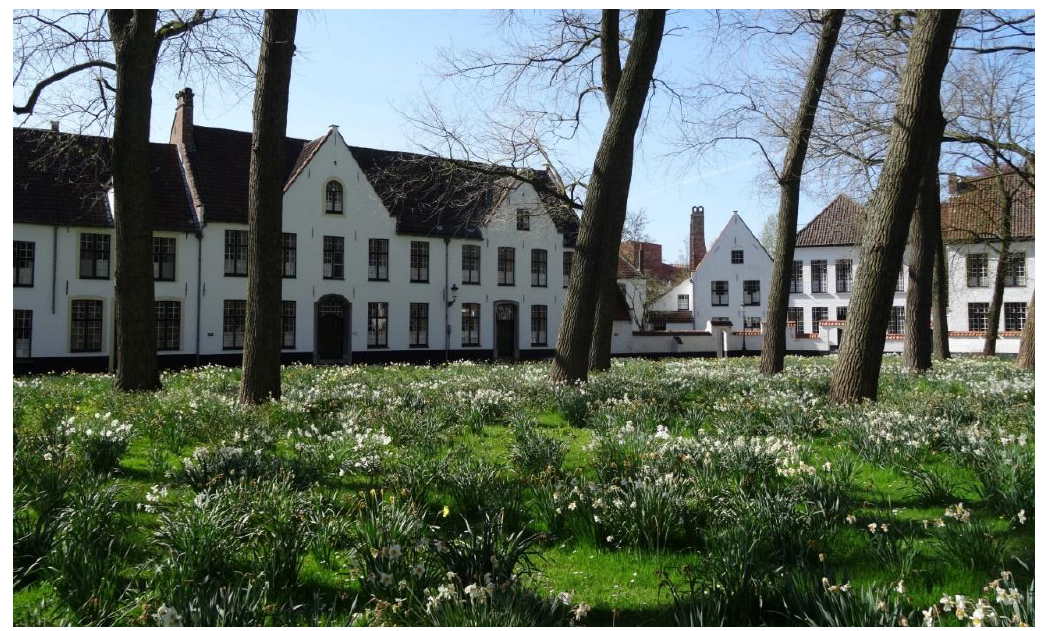
Figure 6. The Beguinage of the Minnewater site in Bruges, Belgium [30].